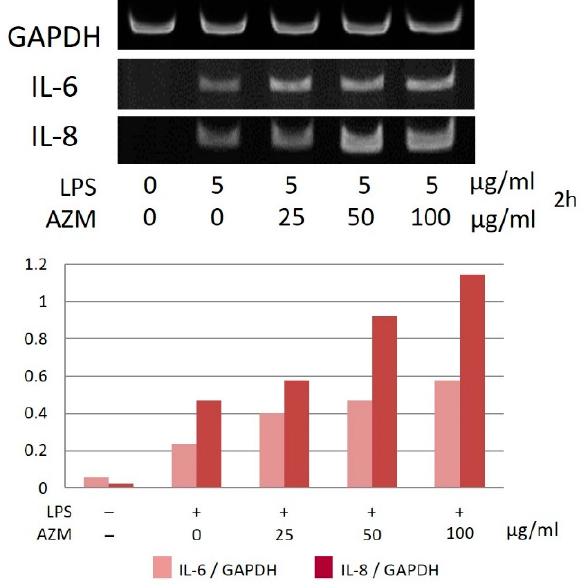
Figure 7. Gene expression of IL-6 and IL-8 in hGFs in the presence of LPS and AZM. The most typical data were shown.